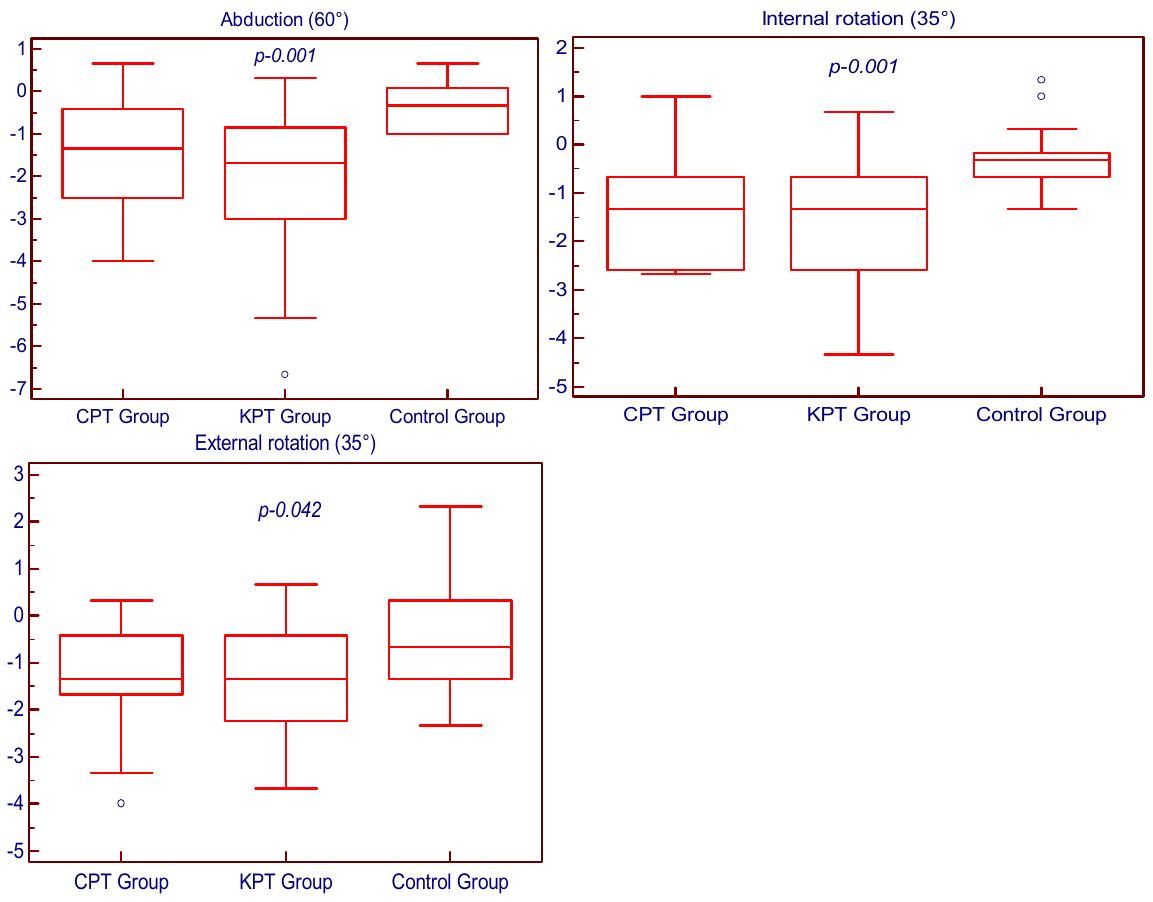
Figure 2. Inter–group comparative analysis of the shoulder JPS. Figure 3. Inter–group comparative analysis of the DASH Outcome Questionnaire